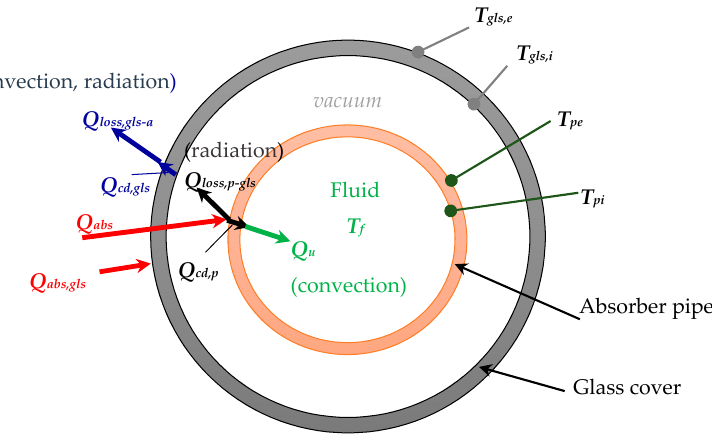
Figure 4. Heat rates associated to the tubular receiver.